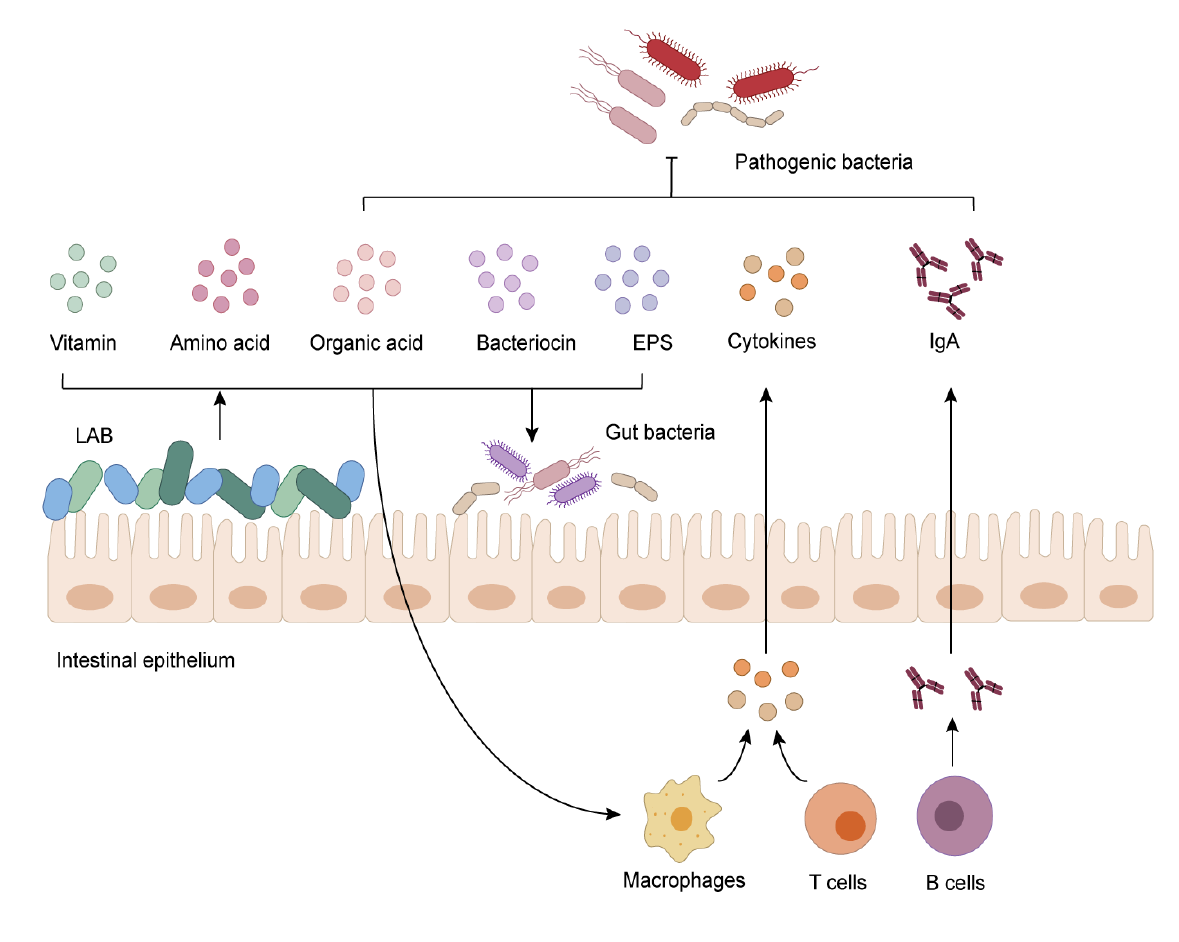
FIGURE 3: The regulatory mechanism of the gut microbiota by LAB. LAB inhibit invasion and colonization of pathogens through occupying adhesion sites and producing metabolites like organic acid, bacteriocin, and EPS. LAB also activate the host innate immune system and pro- mote the secretion of cytokines and IgA, which strengthens the integrity of intestinal mucosa and protects the intestine against